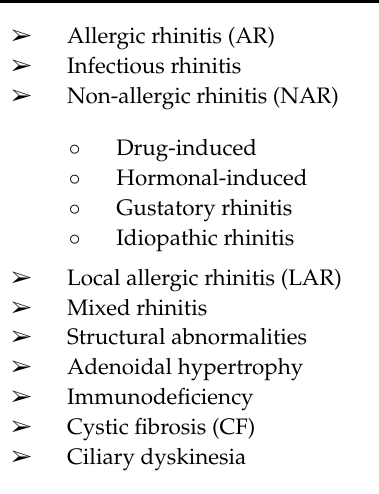
Table 1. Mostcommon causes of chronic rhinitis in the paediatric